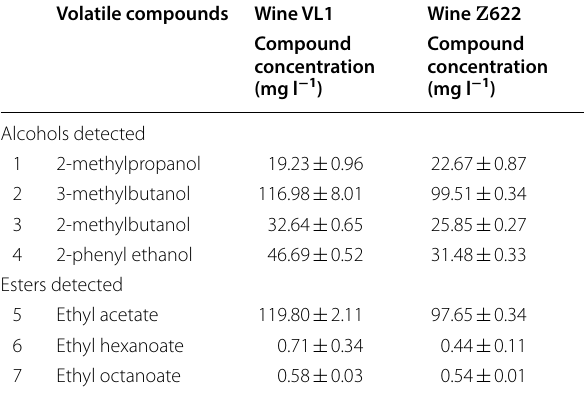
Table 4 Quantitative analysis of volatile compounds in the wines produced by the commercial (VL1) or the indigenous (Z622) yeast strains, on day 6 Volatile